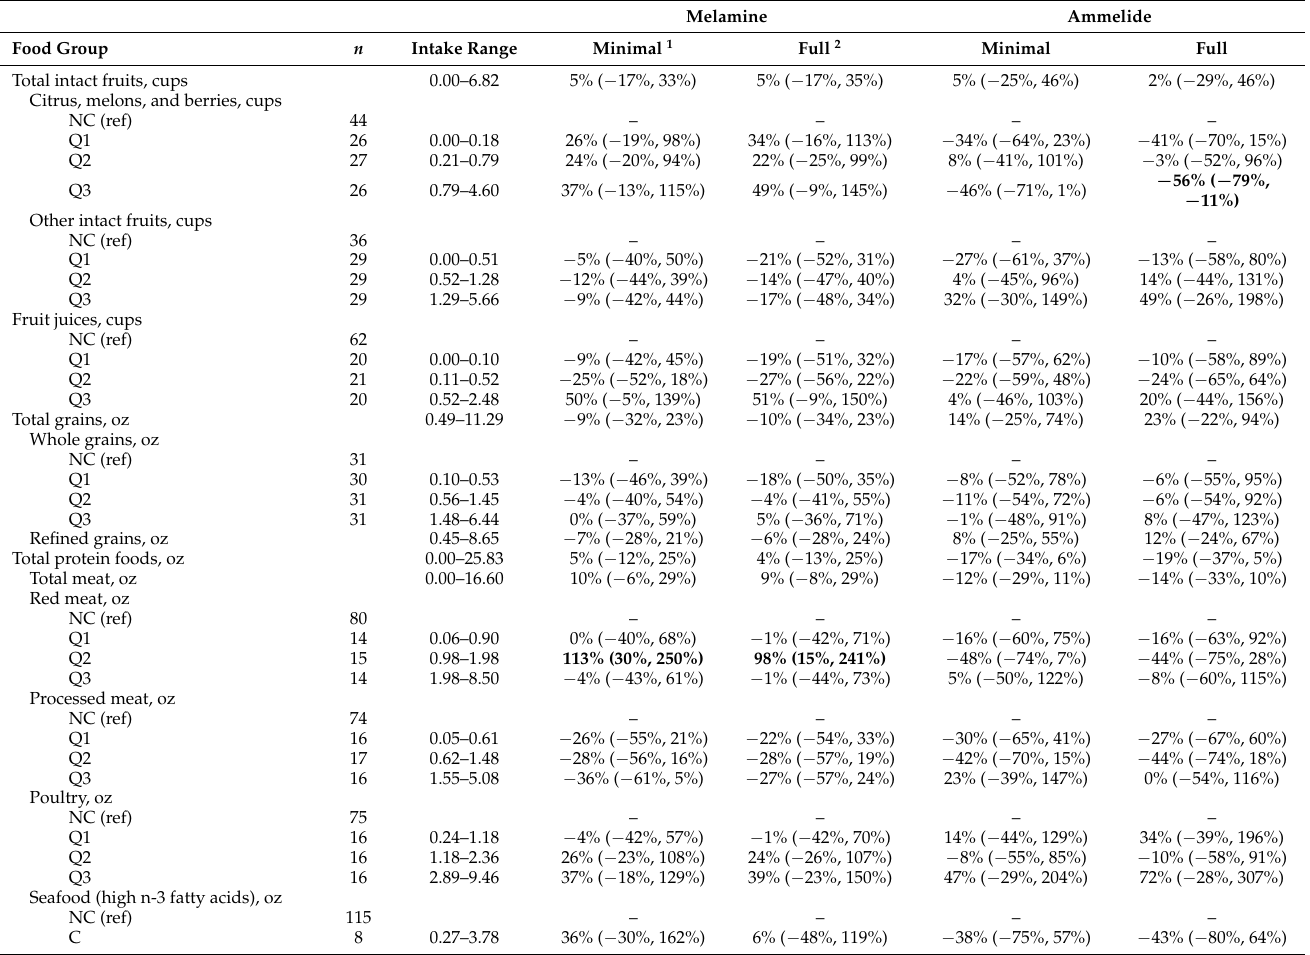
Table A1. Estimated percentage difference (with 95% CI) in urinary melamine or ammelide concen- trations for a 50% increase in consumption (continuous dietary variables) or in comparison to the reference group (categorical dietary